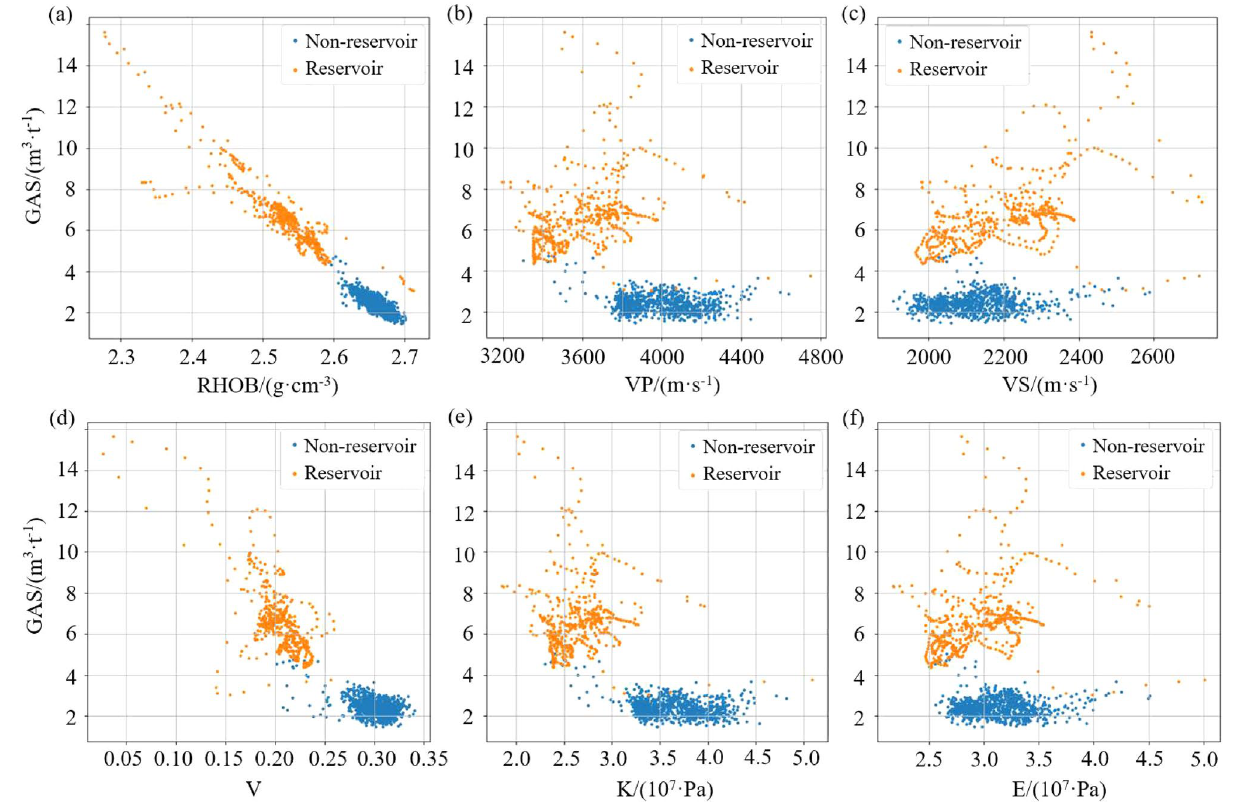
Figure 6. Cross plot of GAS with ( a ) density, ( b ) longitudinal wave velocity, ( c ) transverse wave velocity, ( d ) Poisson’s ratio, ( e ) bulk modulus and ( f ) Young’s